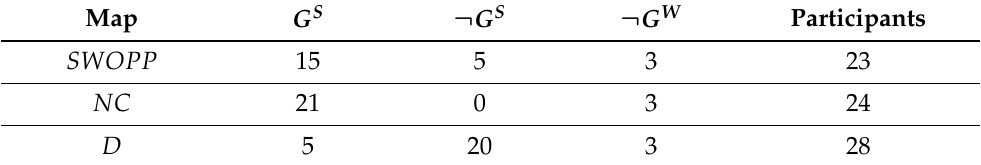
Table 3. Goal performance (achieved G S , not achieved G S , and number of users in each condition).